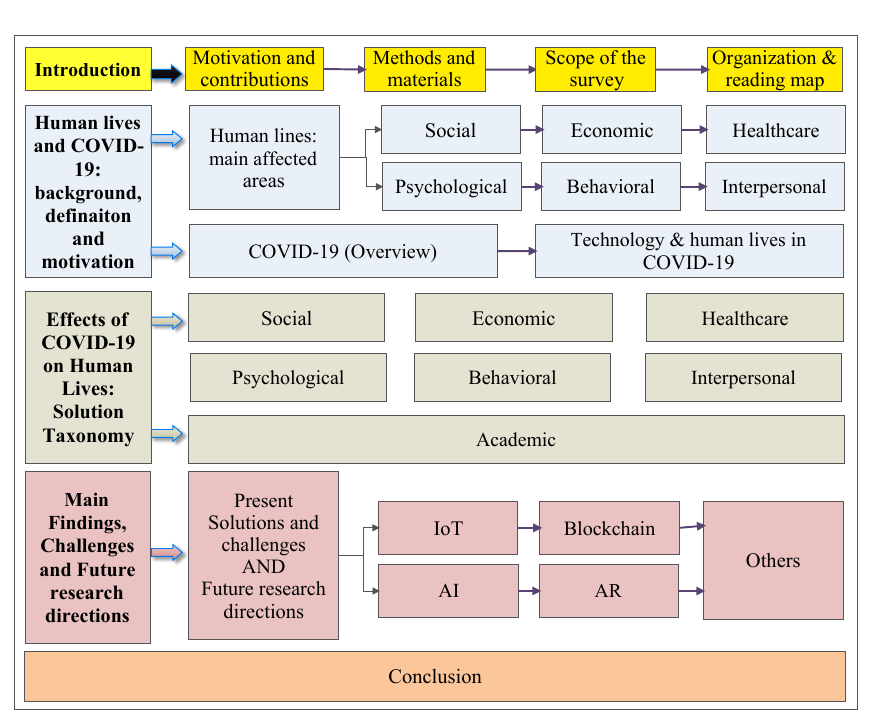
Figure 3. Structure of the review